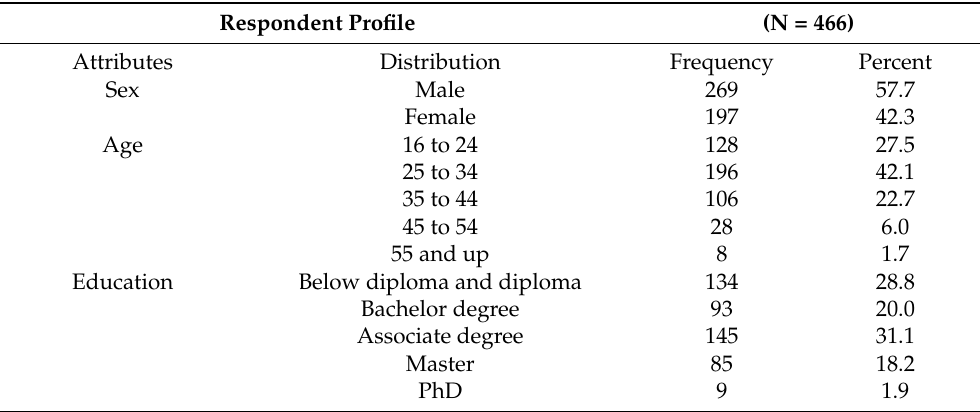
Table 1. Demographic